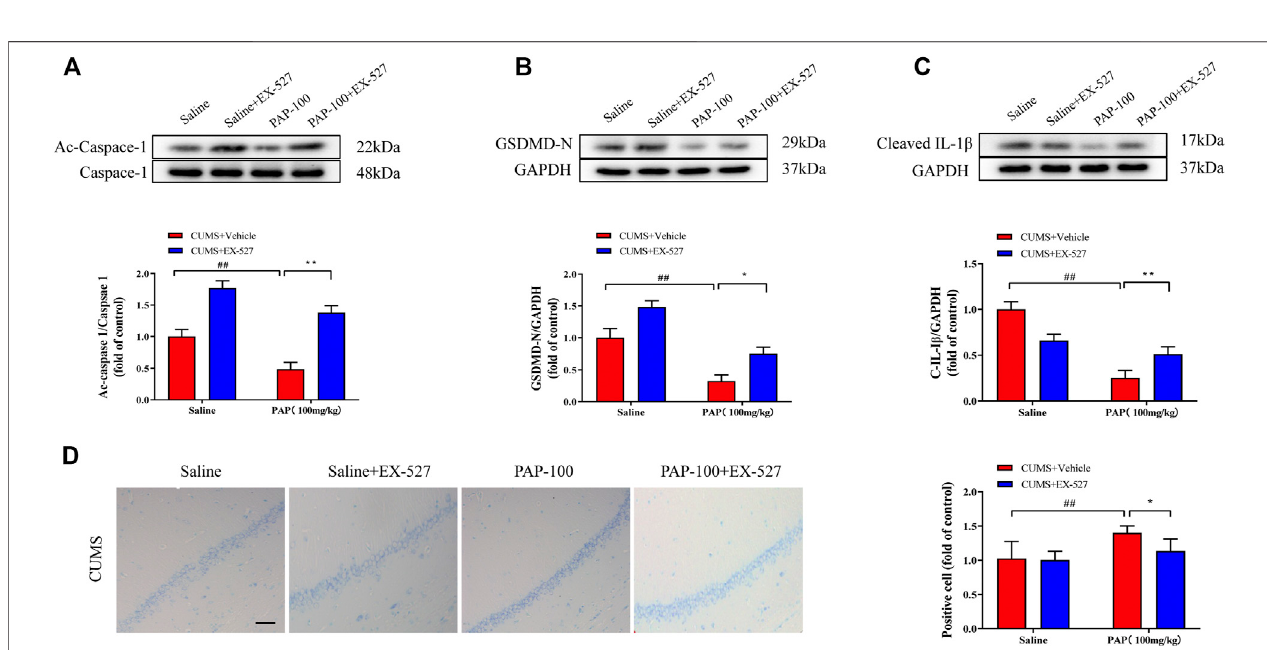
FIGURE5 | Role ofSirt1in the attenuation ofPAP on CUMS-induced depression.The expressionsof Ac-Caspase-1 (A) , GSDMD-N (B) , and Cleaved-IL-1 β (C) in hippocampal tissues. The positive cell in Nissl staining (D) . ## p < 0.01 vs. CUMS + Vehicle, * p < 0.05, and ** p < 0.01 vs. CUMS + Vehicle + PAP group. Scale bar: 100 μ